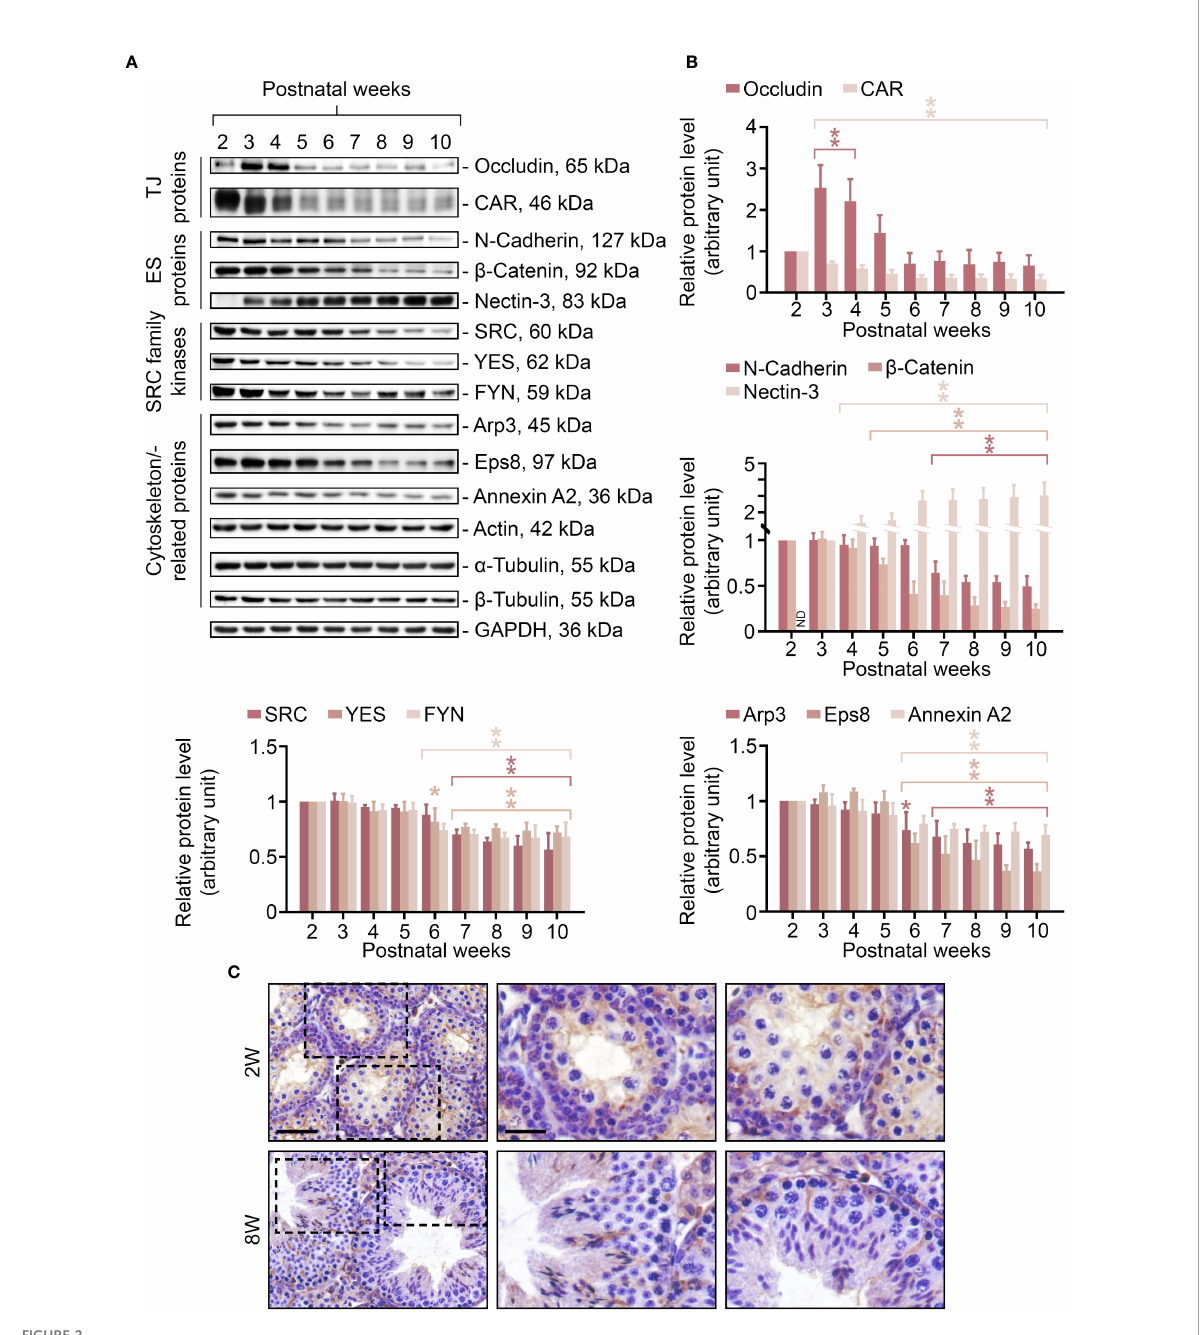
FIGURE 2 Changes in expression levels of FYN and BTB/apical ES-associated proteins in mouse testes during postnatal development. Male mice at 2-10 weeks old were terminated to obtain lysates of testes for immunoblotting experiments (A) . The steady-state levels of TJ proteins (occludin and CAR), ES proteins (N-cadherin, b -catenin and nectin-3), SRC family kinases (including FYN and another two family members SRC and YES, which are known to regulate BTB and apical ES), and cytoskeletal proteins (including actin and its binding proteins Arp3, Eps8, and annexin A2, as well as a - and b -tubulin) were examined. GAPDH was used as an internal control to ensure the equal protein loading across the gel (~50 µg protein/lane). Histograms (B) summarizing the results of immunoblot analysis in (A) . Each data point was fi rst normalized against its corresponding GAPDH result, then against that of “ postnatal week 2 ” (except for nectin-3, for which “ postnatal week 3 ” was used), which was arbitrarily set to 1. Each bar = mean ± S.D. of three independent experiments. *P<0.05; **P<0.01 (Student ’ s t-test). Because the levels of actin, a - or b -tubulin stay constant during the postnatal testis development, the histogram for these proteins is excluded. IHC staining was used to examine the expression and localization pattern of FYN in testes in pups (2W, 2 weeks old) versus adults (8W, 8 weeks old) (C) . 5 m m-thick paraf fi n sections were immunostained using a rabbit anti-FYN polyclonal antibody (Table 1). Boxed areas with a dotted outline in the fi rst column (2W versus 8W) are enlarged and presented to the right in the second and third columns, respectively. Scale bar, 45 m m ( fi rst column) and 20 m m (second column; also applies to the third